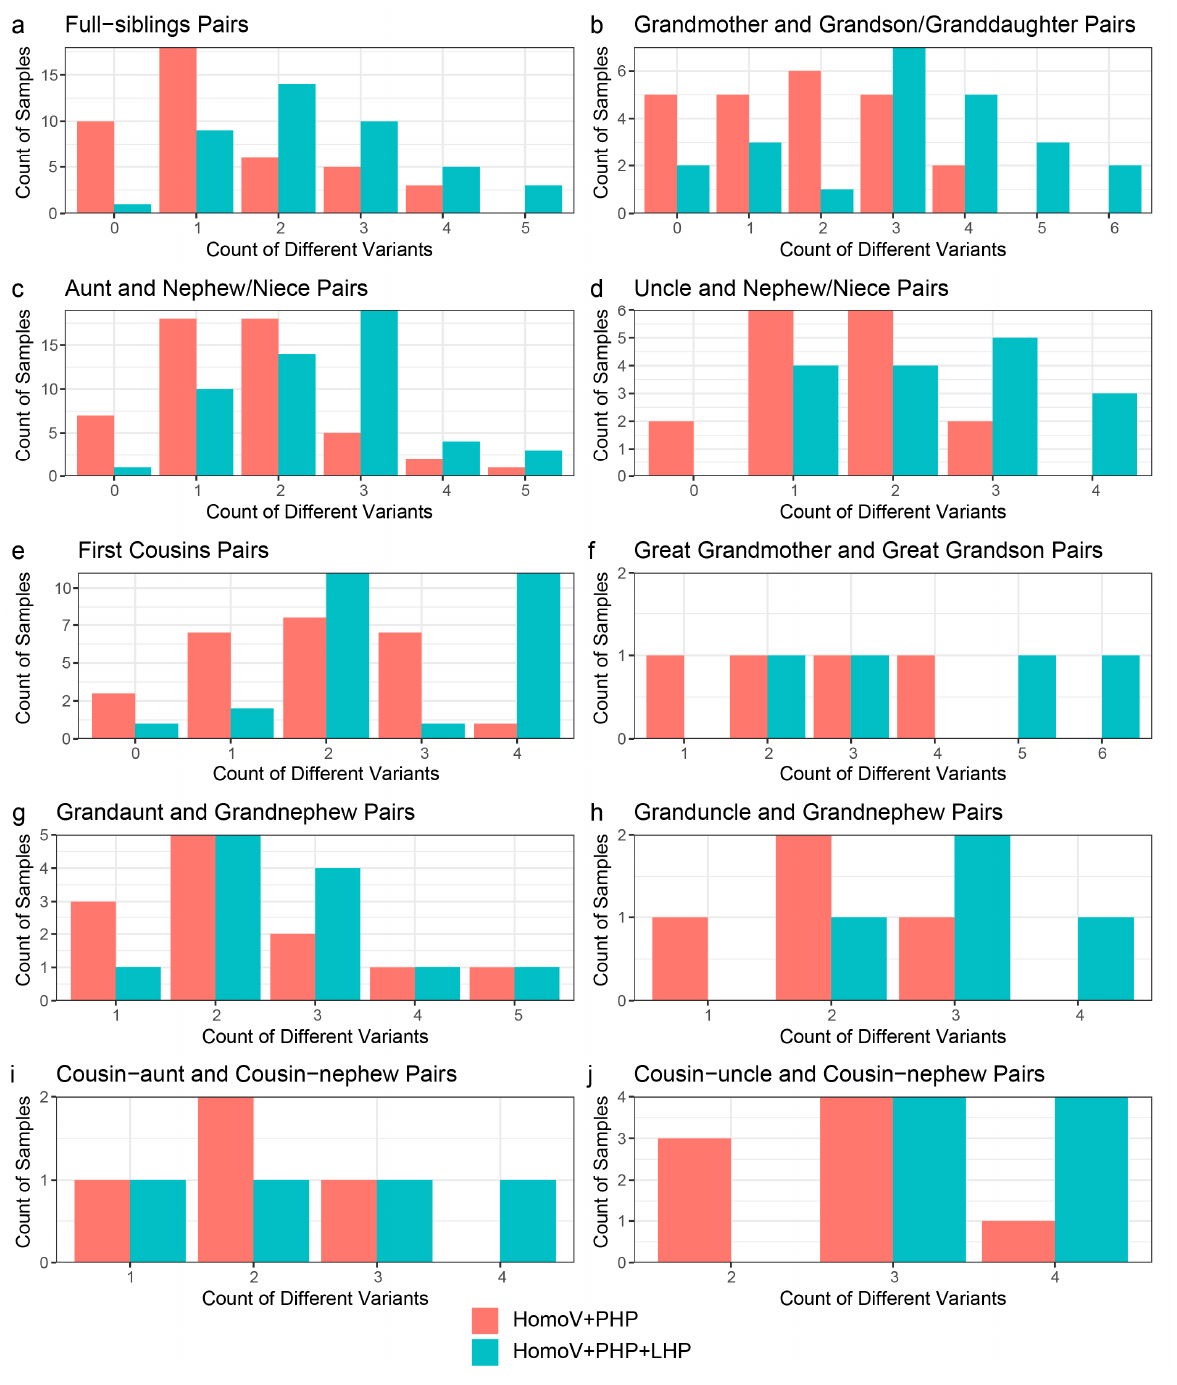
Figure 10. Counts of different variants in the ten types of maternal